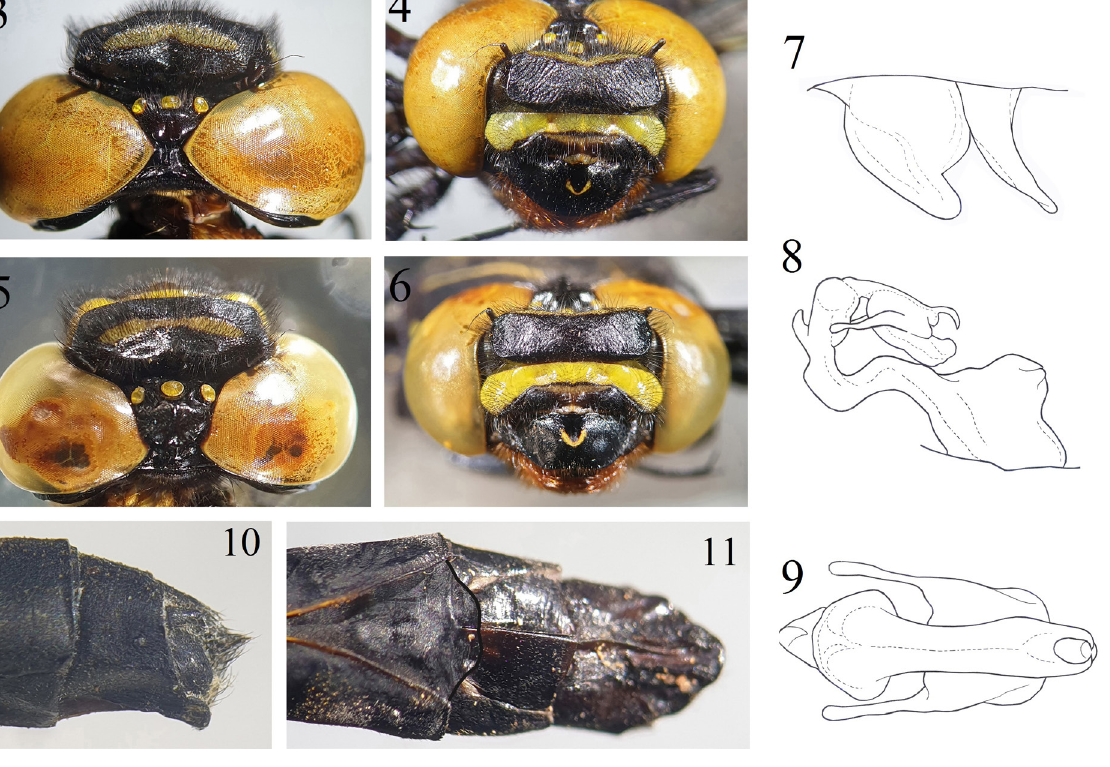
Figs 3–11. Features of Chlorogomphus hoaian sp. nov., holotype, ♂ (3–4, 7–9) (ZCDTU